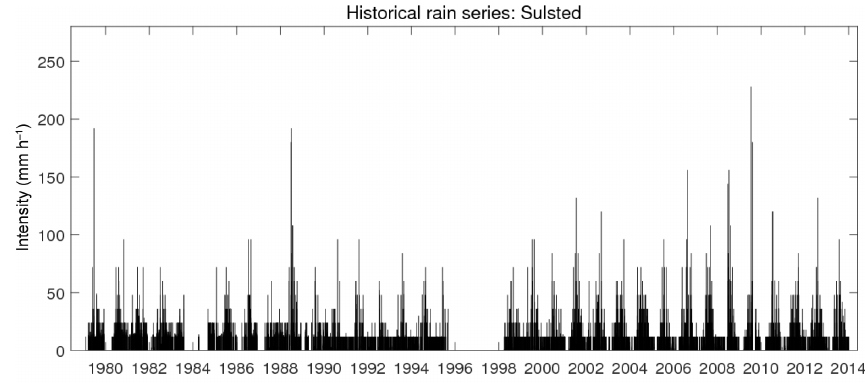
Figure 1. Measured time series of the Sulsted rain gauge. The temporal resolution of rainfall data is 1 min.